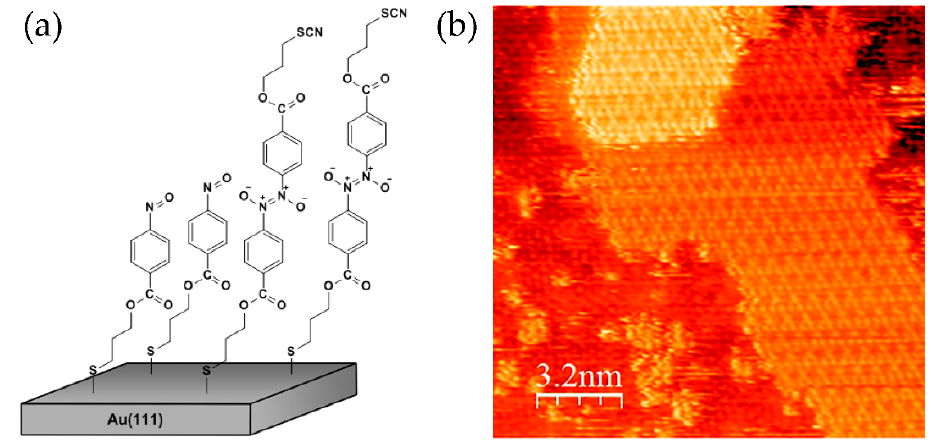
Figure 11. ( a ) Model and ( b ) high-resolution STM image of mono- and bilayer domains of nitrosobenzene molecules on an Au(111) surface. Reproduced with permission from [64]. Copyright 2011 American Chemical